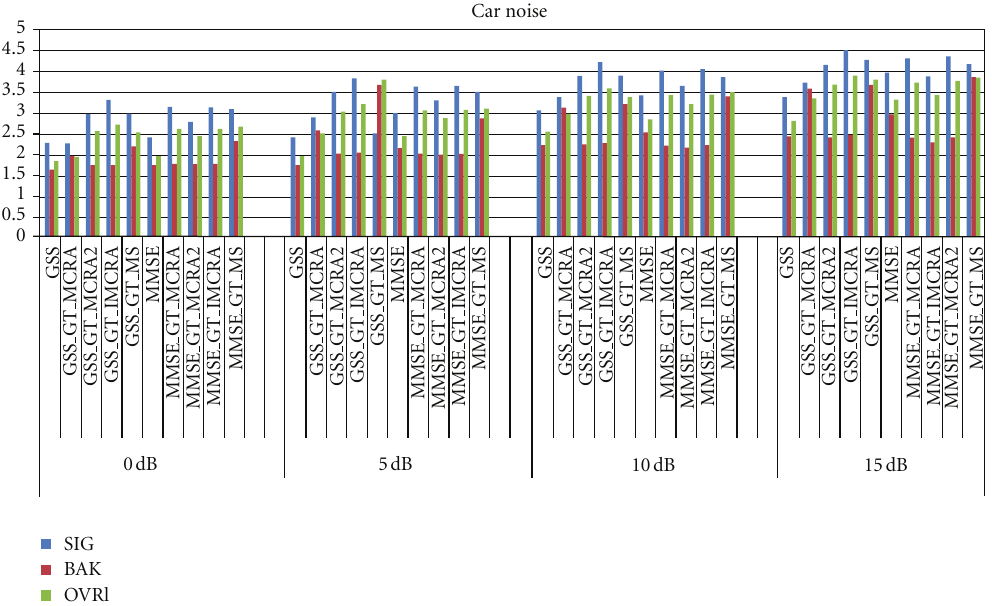
Figure 8: SIG-BAK-OVRL scores for proposed speech enhancement with the gammtone decomposition compared to the GSS and the MMSE at di ff erent SNR input for car noise.